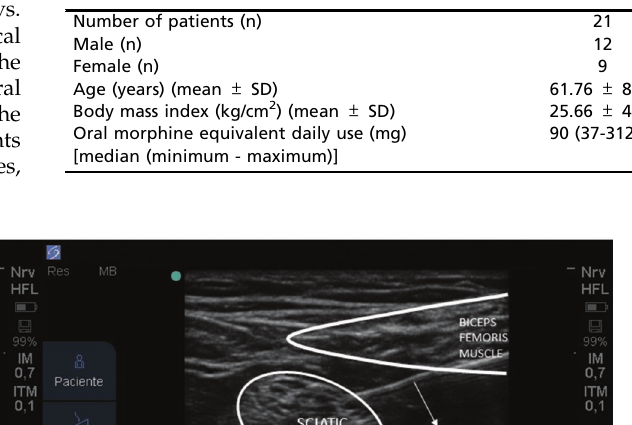
Table 1 - Demographic and baseline data (before CPNB).